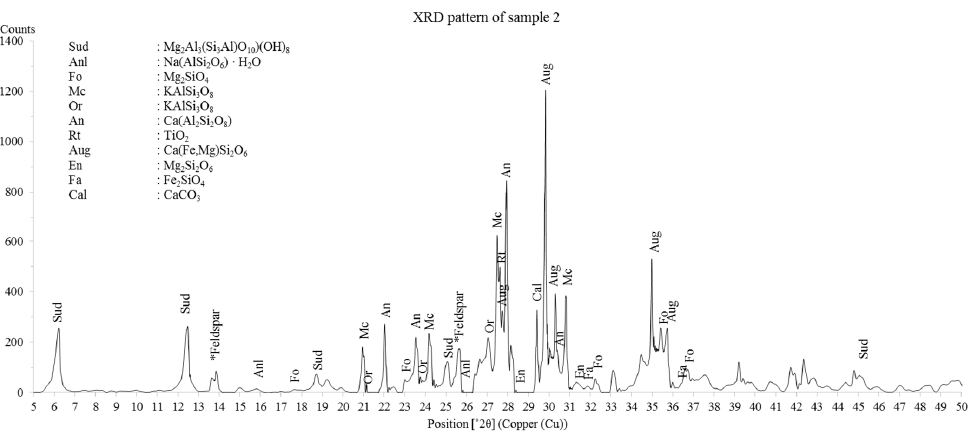
Figure 4. XRD analysis of sample 1 from Segamat basalt (Chl:chlorite, Sud: sudoite, *Feldspar: common feldspar group peak, Anl: analcime, Afs: alkali feldspar, Mc: microcline, An: anorthite, Fo: forsterite, Or: orthoclase, Rt: rutile, Aug: augite, Hyp: hypersthene, Cal: calcite, En: enstatite, Fa: fayalite).